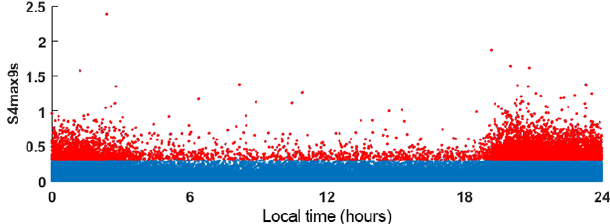
Figure 2. Plot of S4max9sec as a function of local time (LT) during 2014. The blue dots represent the scintillation index less than 0.3, whereas strong scintillations are represented by the red dots with an S4 index larger than